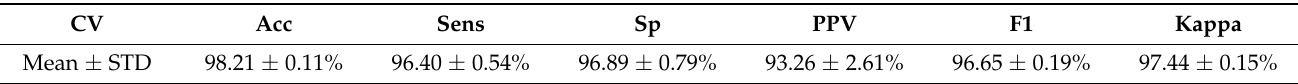
Table 19. Average classification performances including Acc, Sens, Sp, PPV, F1, and kappa.